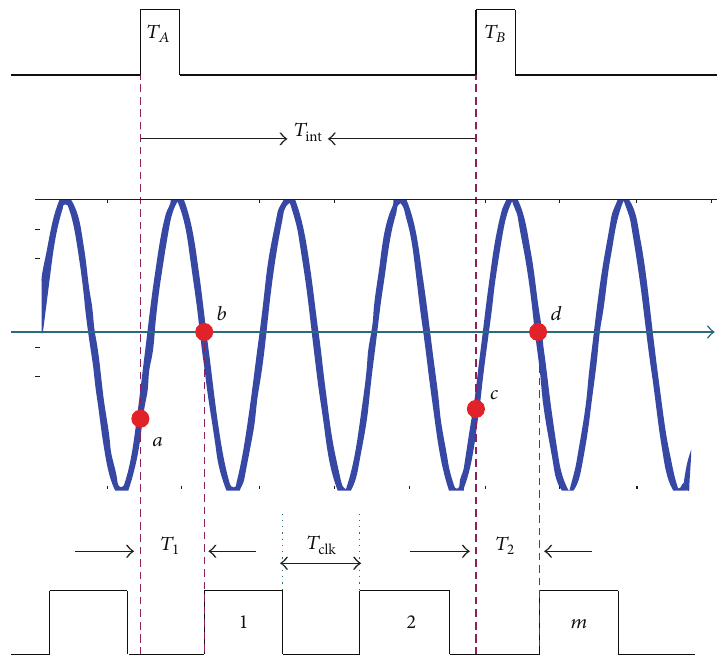
Figure 4: One time-interval measurement